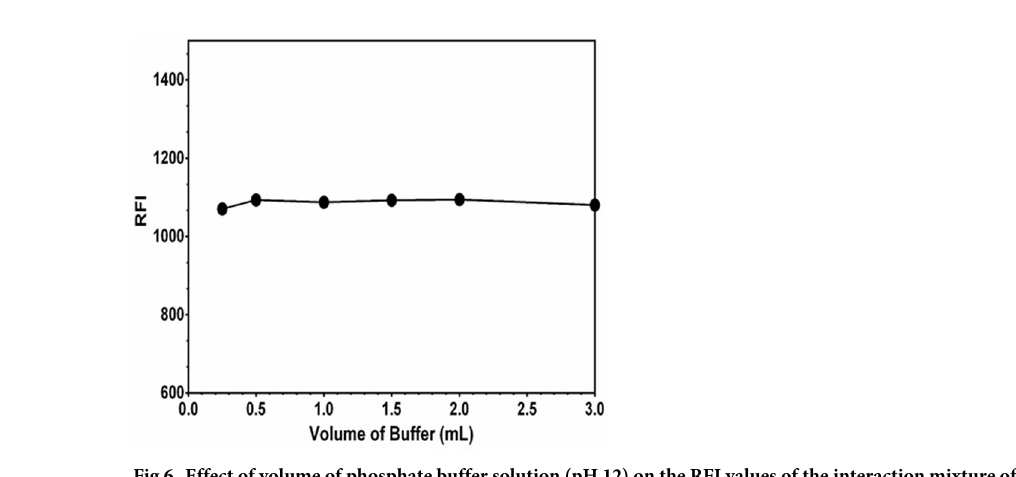
Fig 6. Effect of volume of phosphate buffer solution (pH 12) on the RFI values of the interaction mixture of LAP (1000 ng/mL) with kolliphor (2%, w/v).